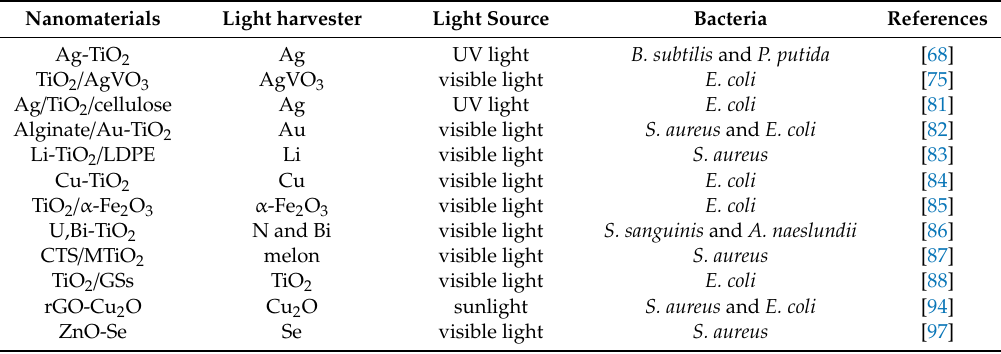
Table 1. Light-activated nanomaterials for antibacterial application in this